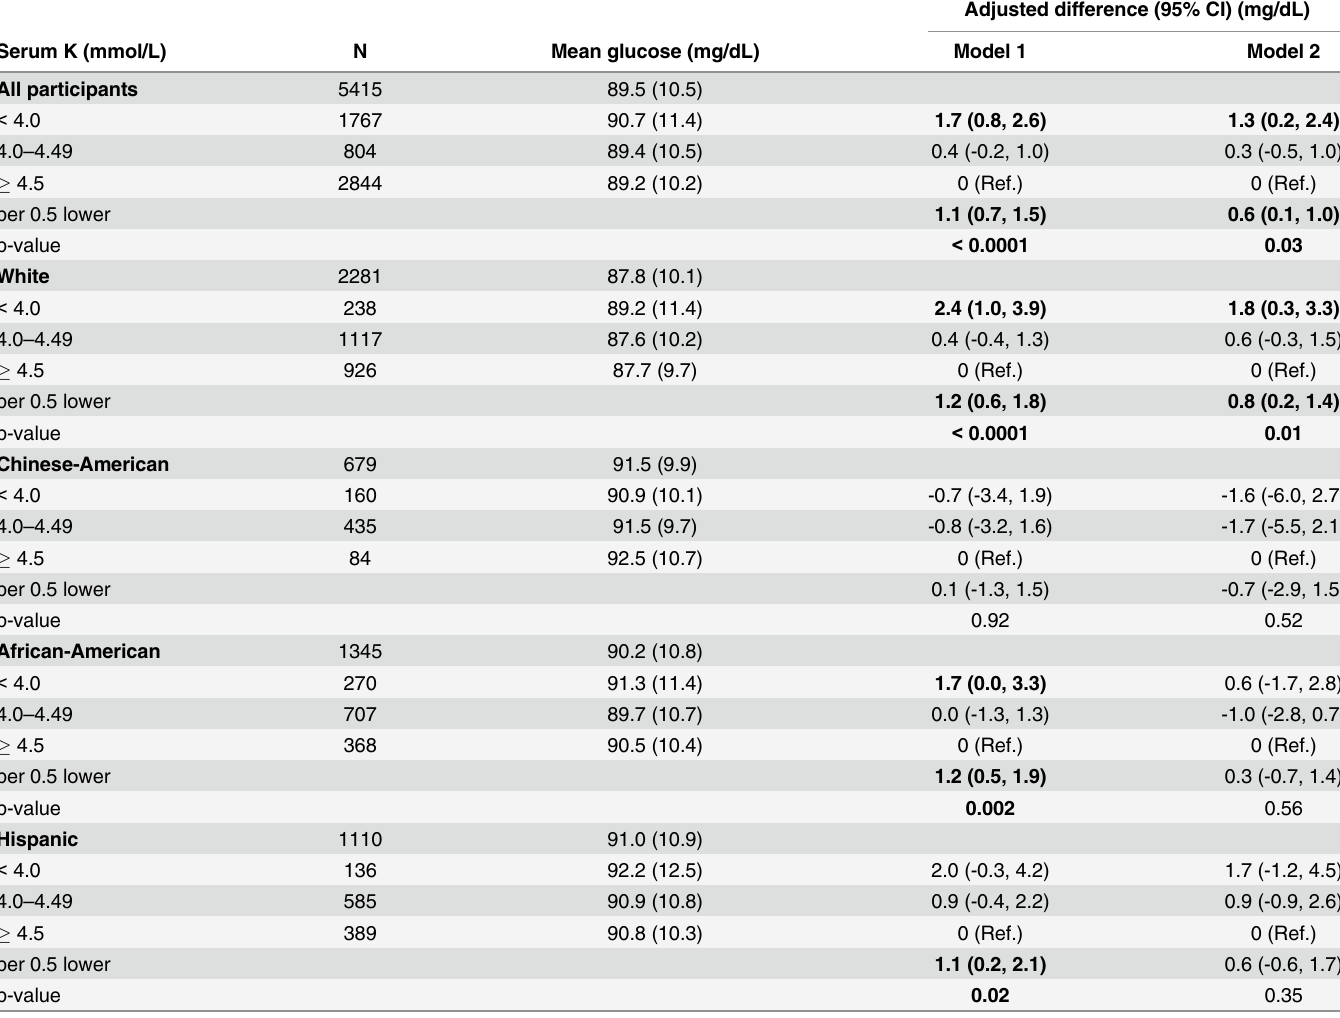
Table 2. Associations Between Serum Potassium and Fasting Glucose, by Ethnicity (N = 5415).